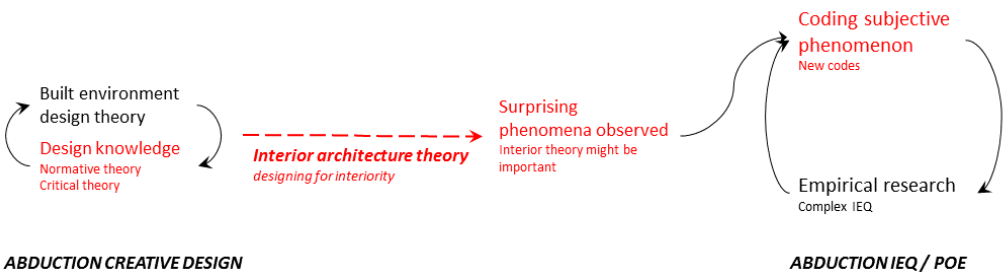
Figure 2. Pathway for introducing interior architecture theory into IEQ, based on Figure 1.